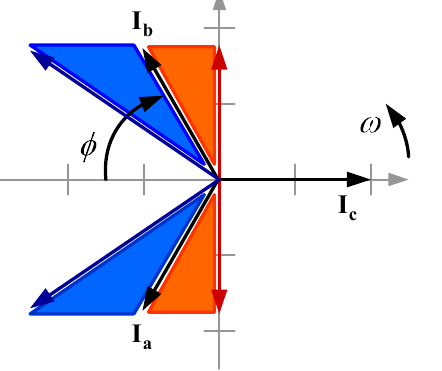
supply to an induction motor.